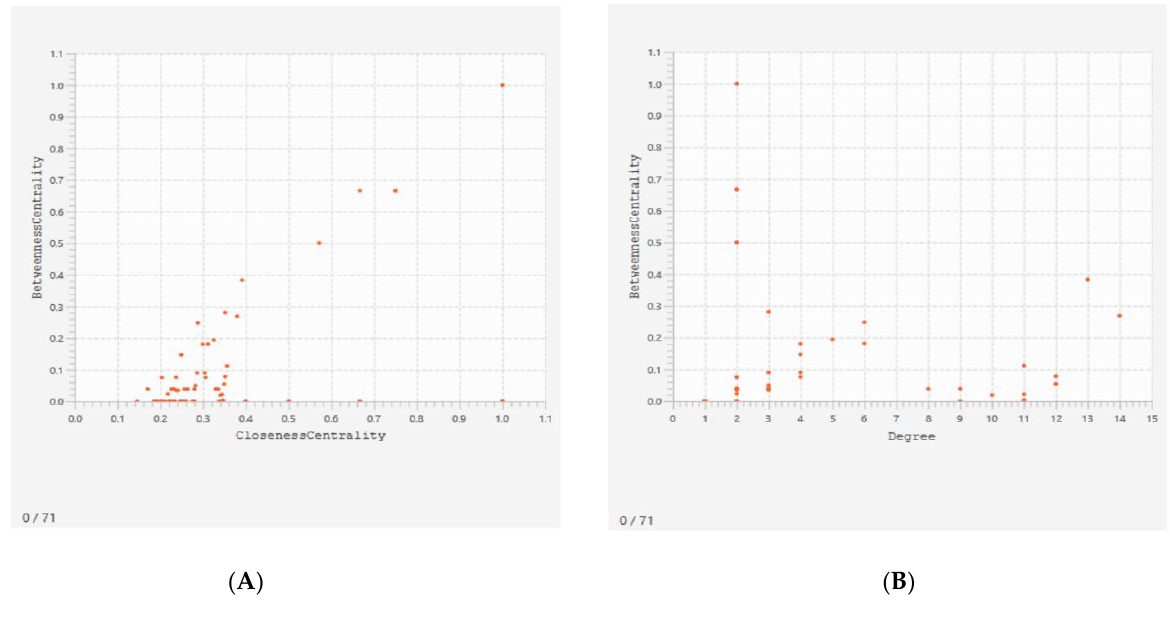
Figure 9. Scatterplots constructed to visualize the position of proteins in the plot with different values of betweenness centrality, closeness centrality, and degree of values. ( A ) Scatterplot between the betweenness centrality and closeness centrality; ( B ) Scatterplot between the betweenness centrality and degree of values. Table 3. List of top 20 interactions common to teratozoospermia and azoospermia from a protein- protein analysis using the STRING application of Cytoscape. The genes are arranged in descending order of their degree of centrality, along with their respective average shortest path length, between- ness centrality, closeness centrality, and the clustering